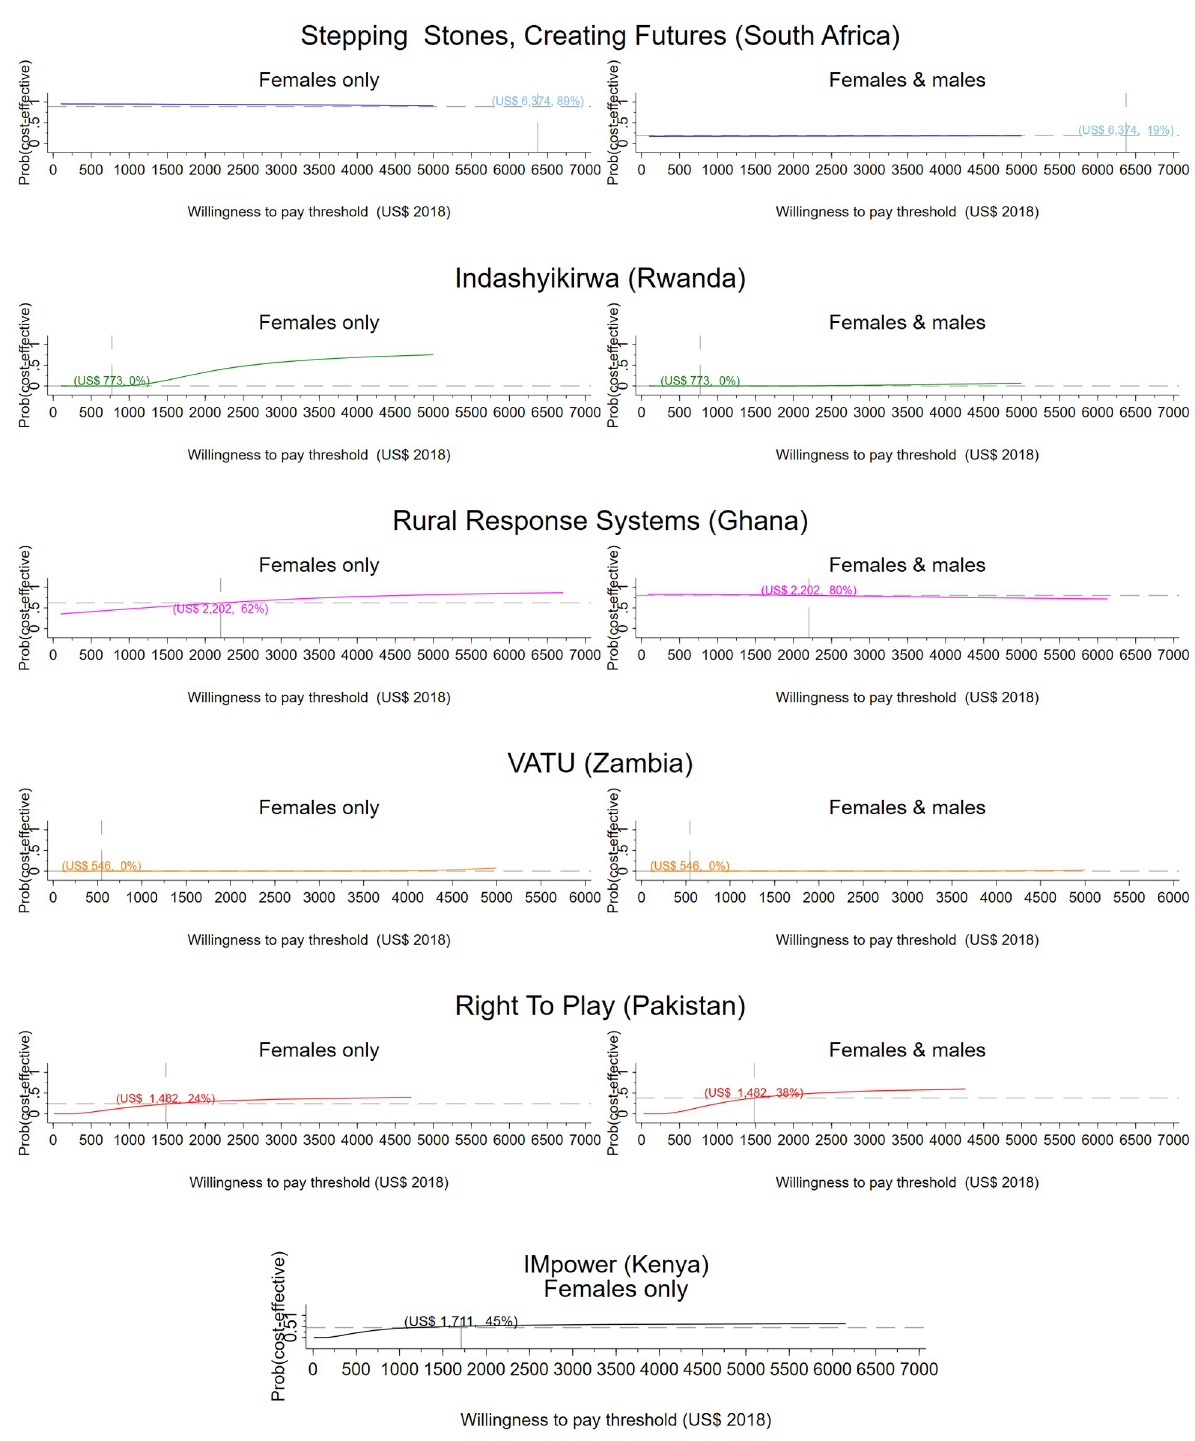
Fig 2. Research setting, societal perspective. CEACs illustrating the probability that the intervention is effective for a range of thresholds. Dashed vertical line: country-specific opportunity cost threshold; dashed horizontal line: probability that the intervention is cost-effective at the country- specific threshold, given the cost per DALY averted by the intervention. CEAC, cost-effectiveness acceptability curve; DALY, disability-adjusted life year; VATU, Violence and Alcohol Treatment.